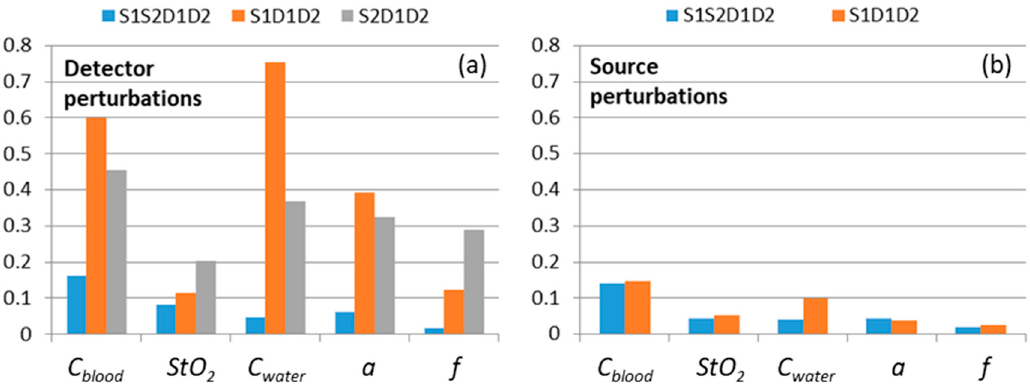
Figure 8. Relative deviations in C blood , StO 2 , C water , a , and f values reconstructed using self-calibrating (S1S2D1D2) and single-slope (S1D1D2 and S2D1D2) approaches from the unperturbed measurement values. Relative deviations are averaged over different types of detector ( a ) and source ( b ) perturbations for each reconstructed value. Note that the plot (b) does not contain S2D1D2 data since perturbations introduced to the S1 channel provide no impact on these measurements.